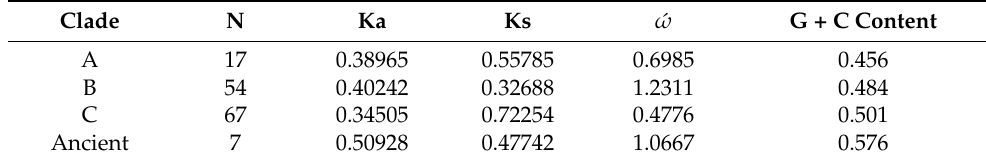
Table 2. Molecular evolutionary analysis of the WRKY66s using their whole cDNA sequences. N, number of sequences; Ka, the number of nonsynonymous substitutions per nonsynonymous site; Ks, the number of synonymous substitutions per synonymous site; ´ ω , Ka/Ks. Clade N Ka